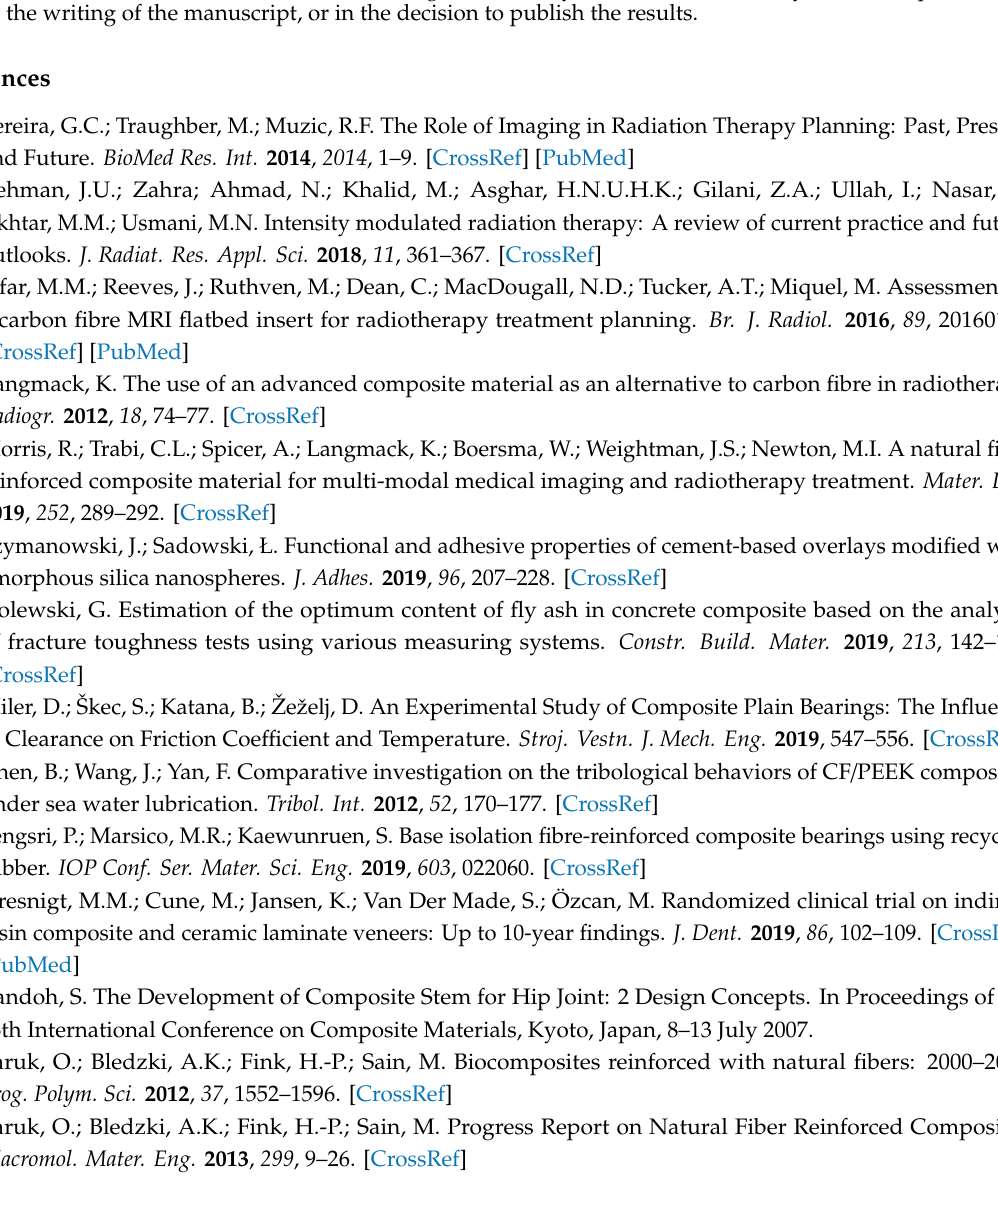
Figure S1: Comparison of treated and untreated samples for compressional testing, Figure S2: MRI data collected at 3T plotted as a function of flexural modulus for each of the material samples, Figure S3: Comparison between the tensile force of the fabric and the resulting flexural modulus of the